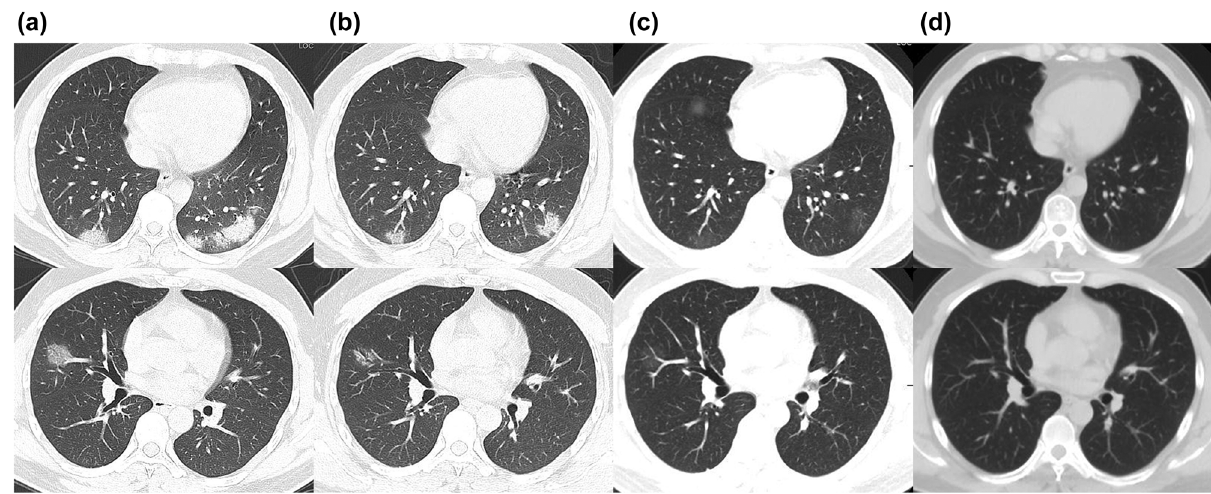
Figure 1: Chest CT images of the patient. ( a ) Multiple nodular and patchy high - density shadows on February 6; ( b ) Partial absorption of multiple nodular and patchy high - density shadows with ground - glass opacity on February 13; ( c ) Most absorbed with few parts of ground - glass opacity on March 5; ( d ) Normal CT image on April